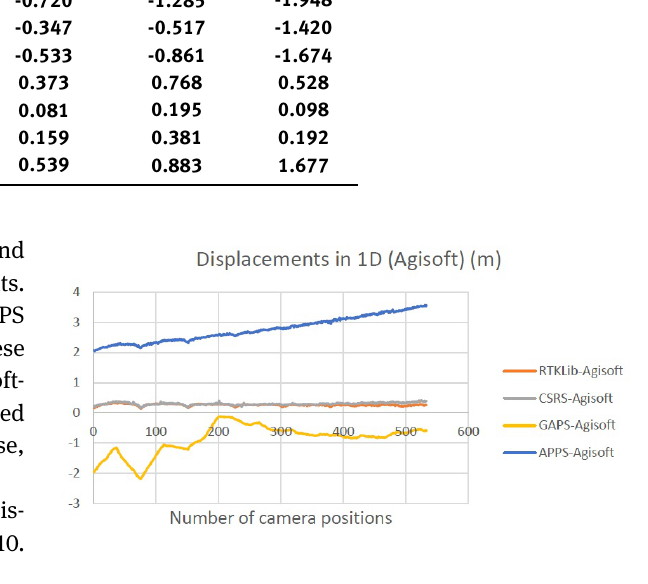
Fig. 11. Displacements in 1D between the coordinates that were produced by Agisoft Metashape and the software utilized in this project.